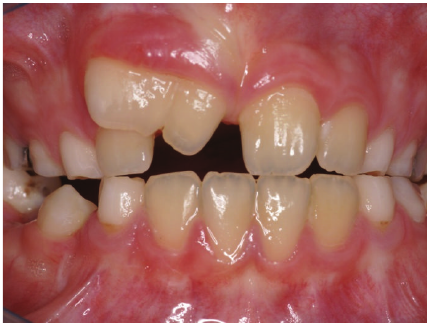
Figure 1: Clinical appearance of fused